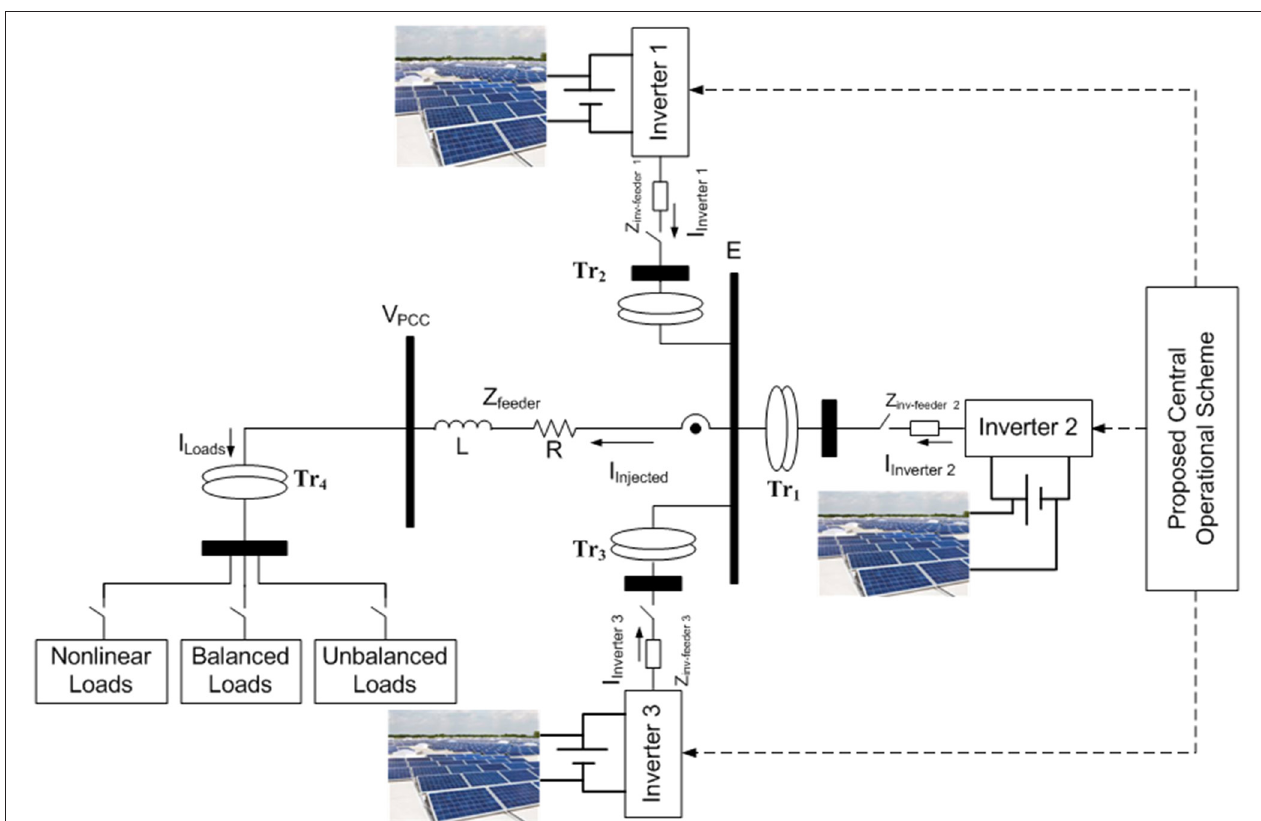
FIGURE 1 | Microgrid under